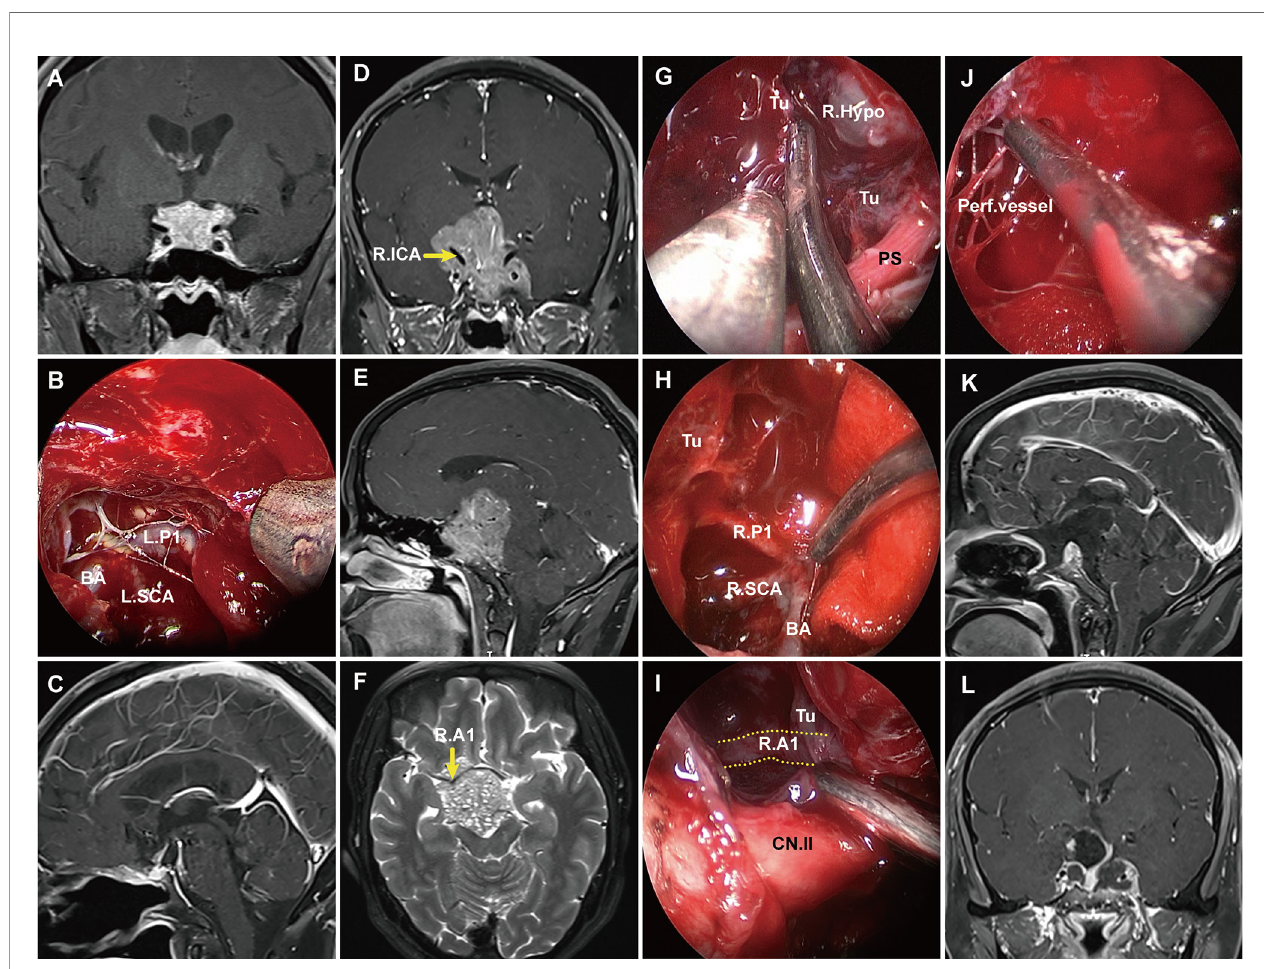
FIGURE 6 | Pre- and postoperative magnetic resonance imaging (MRI) demonstrating two cases of grade 2 pituitary adenoma. (A) A grade 2 PA that extended to the suprasellar region and grew along with the suprasellar cistern. (B) Endoscopic views showing the tumor entered into the arachnoid spaces and encased vital neurovascular structures. (C) postoperative MRI showing gross total resection. (D – F) Preoperative T1 contrast-enhanced images showing a grade 2 tumor signi fi cantly extended to the suprasellar and encircled vital neurovascular structures. (G – J) Endoscopic views showing the tumor entered into the suprasellar space and encased vital neurovascular structures. The tumor grew in grid-like structures formed by the perforating vessels (J) . (K, L) Postoperative T1 contrast-enhanced MRI demonstrating subtotal resection of the suprasellar component of adenoma. PS, pituitary stalk; PG, pituitary gland; Tu, tumor; R. A1, right A1 segment of anterior cerebral artery; R. P1, right P1 segment of posterior cerebral artery; SCA, superior cerebellar artery; BA, basilar artery; R. Ht, right